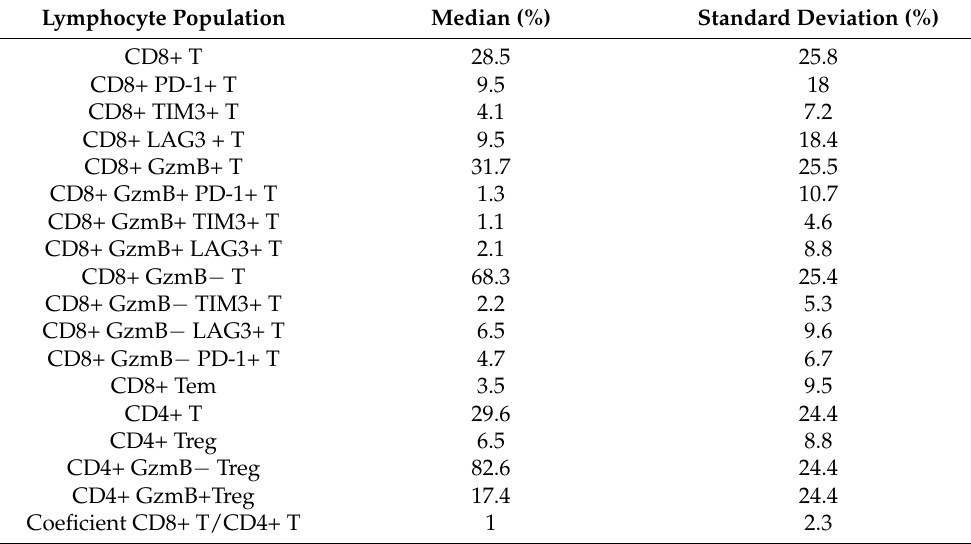
Table 2. Distribution of T lymphocyte populations